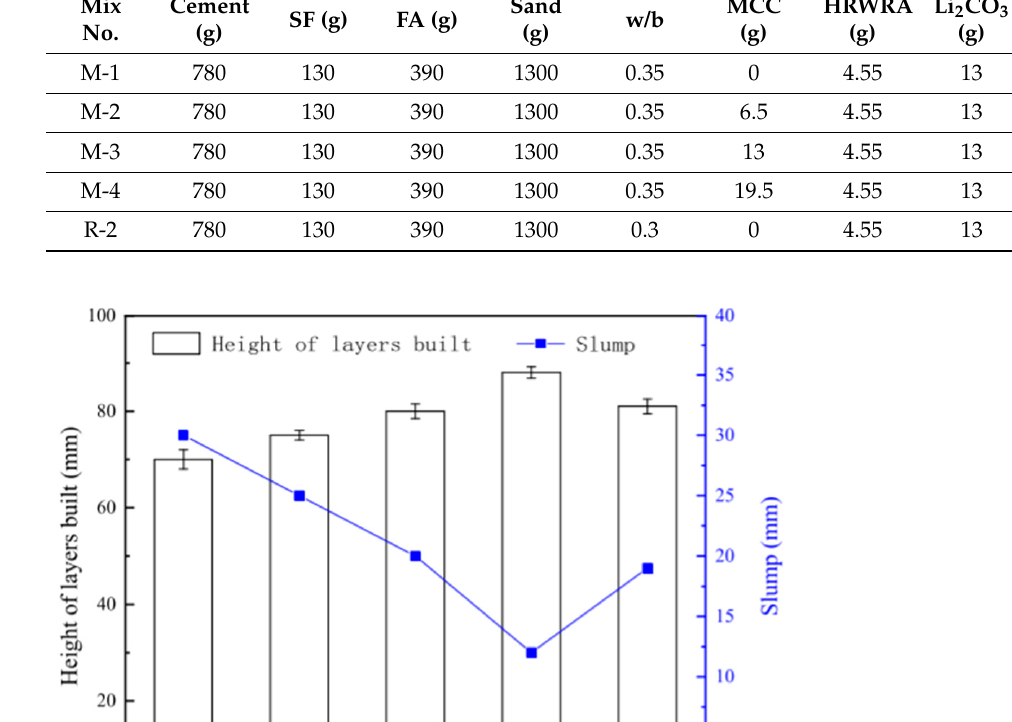
Figure 6. The structure slump was used to characterize the buildability of the mixture. Yuan et al. [31] used a loading device to detect the deformation of the 20-layer printing structure. The loading rate was set according to the printing construction plan. When the deformation was less than 0.2%, it was deemed to meet the construction